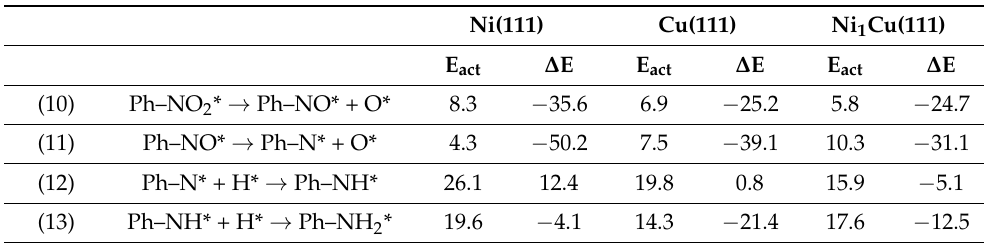
Figure 5. Calculated energy profiles for nitrobenzene hydrogenation to aniline on Ni(111), Cu(111) and Ni 1 Cu(111) surfaces, and optimized structures of the stable minima on the bimetallic catalyst model. Cu, Ni, C, N, O and H atoms are depicted as orange, green, gray, blue, red and white balls, respectively. Table 3. Calculated activation (E act ) and reaction ( Δ E) energies in kcal/mol for nitrobenzene hydro- genation on mono- and bimetallic non-noble metal catalysts.